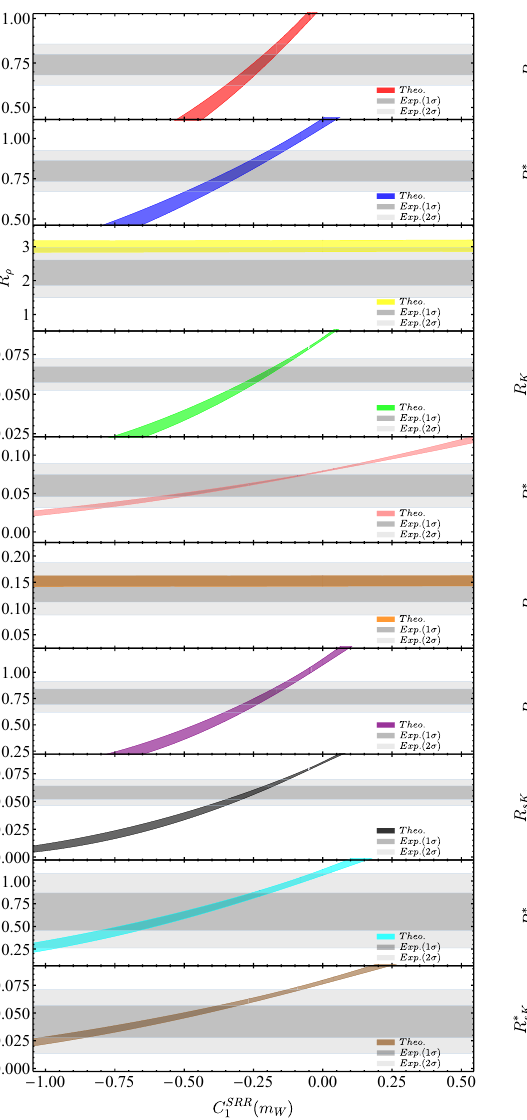
Figure 13 . Constraints on the NP Wilson coefficients C SRR